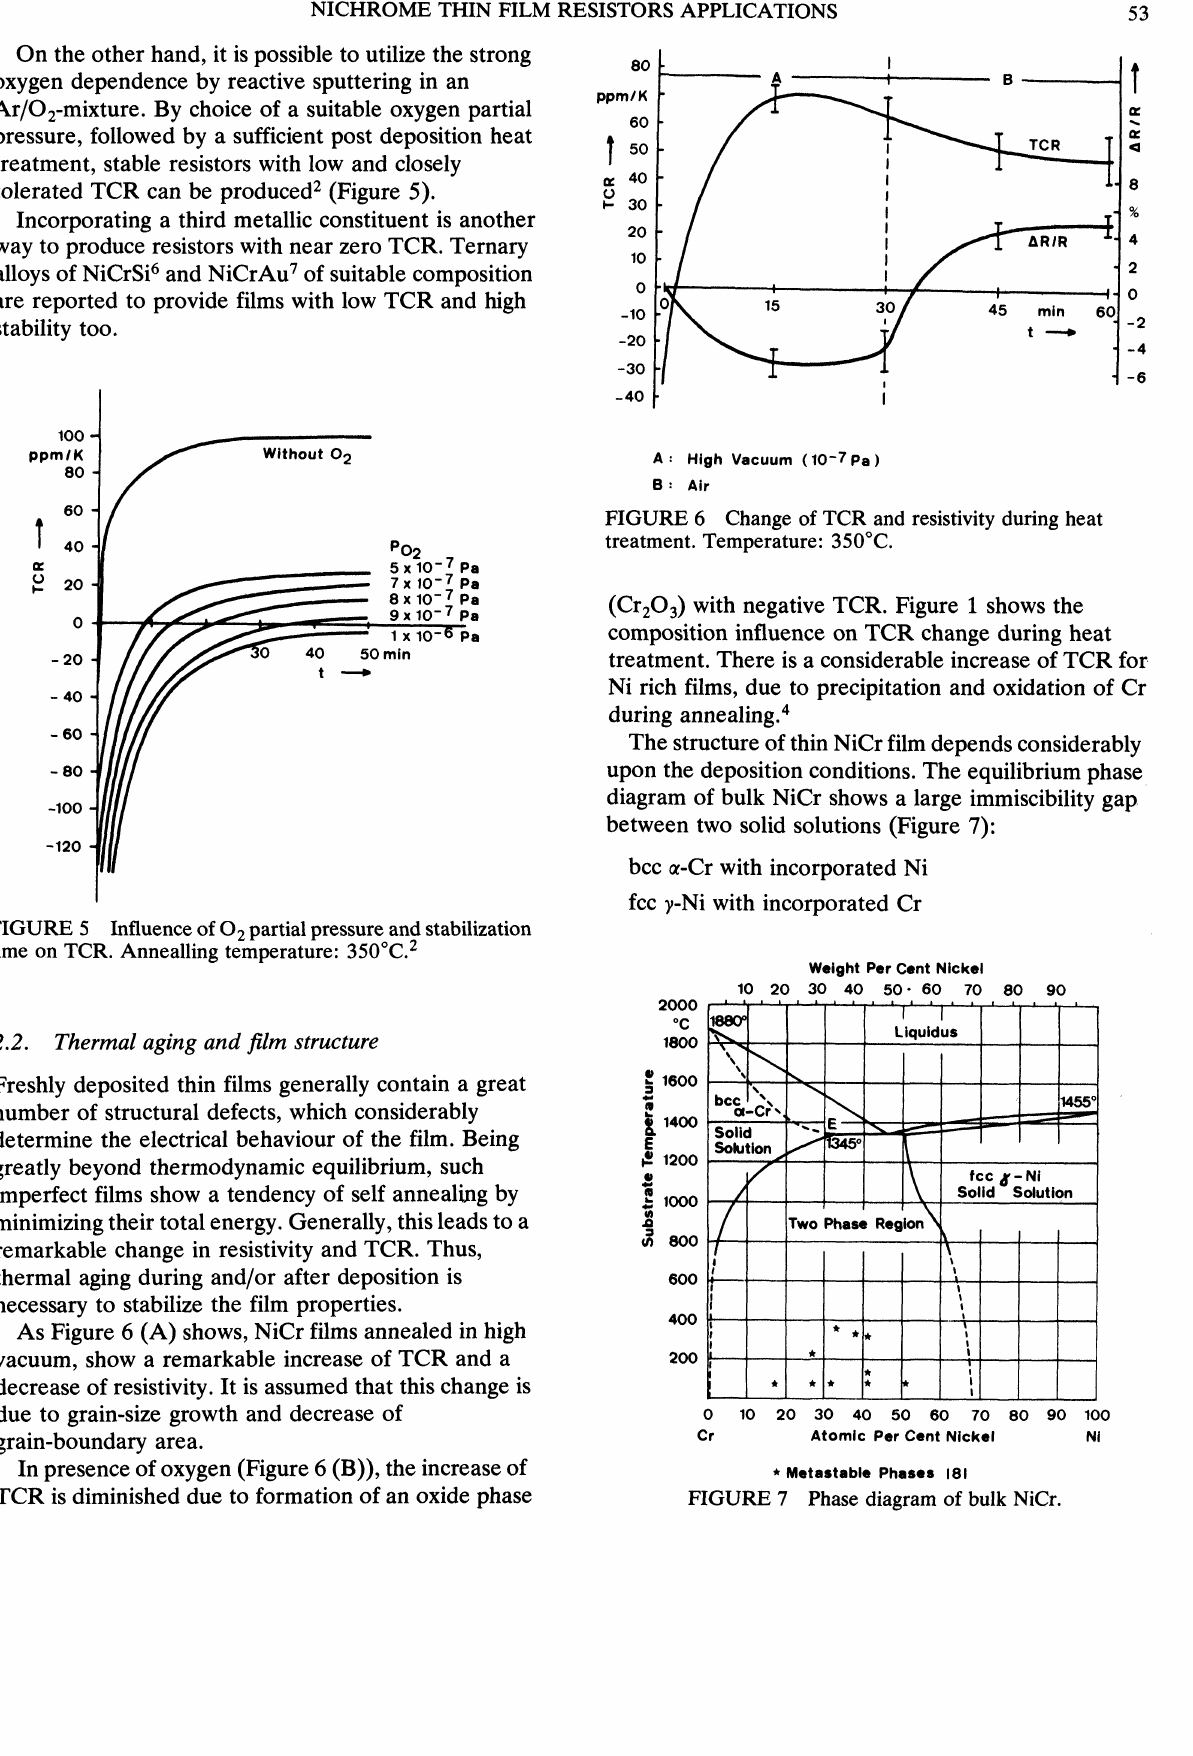
Metastable Phases 181 FIGURE 7 Phase diagram of bulk